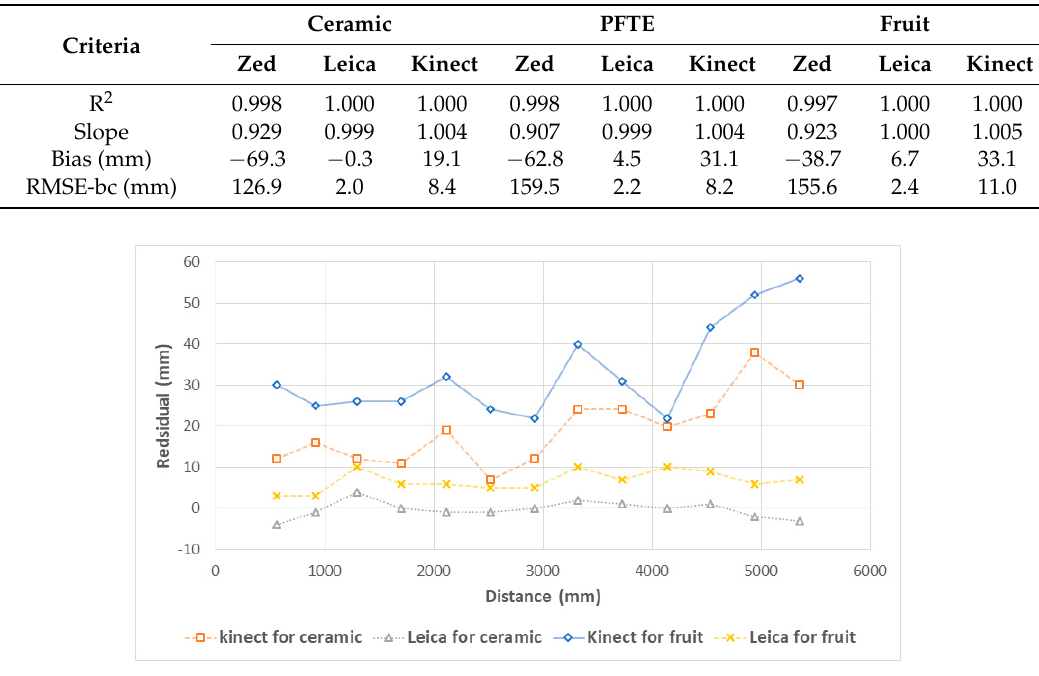
Figure 4. Plot of residual of measured to actual distance from device to object as a function of distance to a ceramic tile and to a fruit for Kinect and DISTO technologies (Zed camera results could not be shown on this y scale). Solid lines are used for ceramic measurements, dotted lines for fruit.